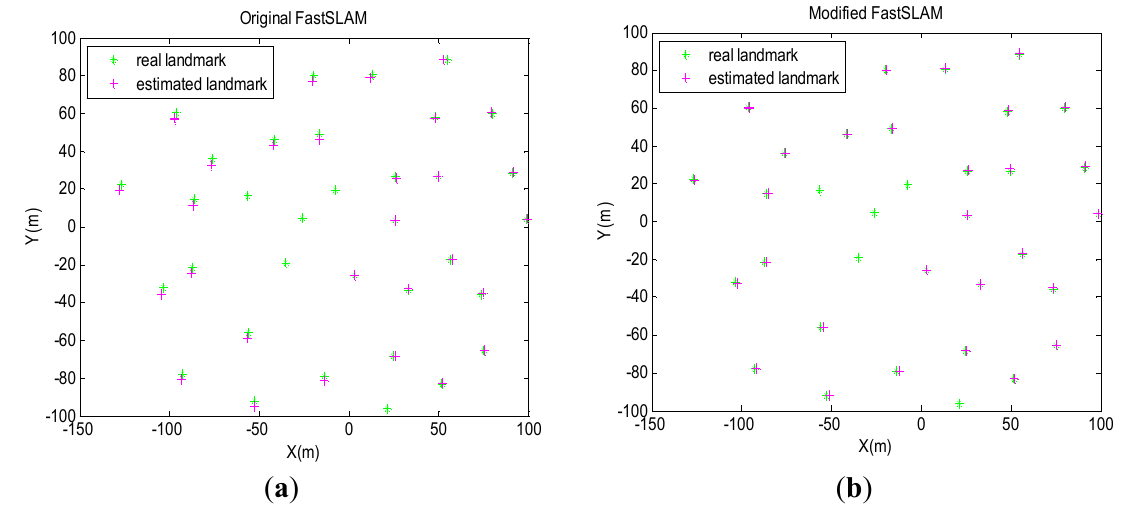
Figure 5. Data association results.